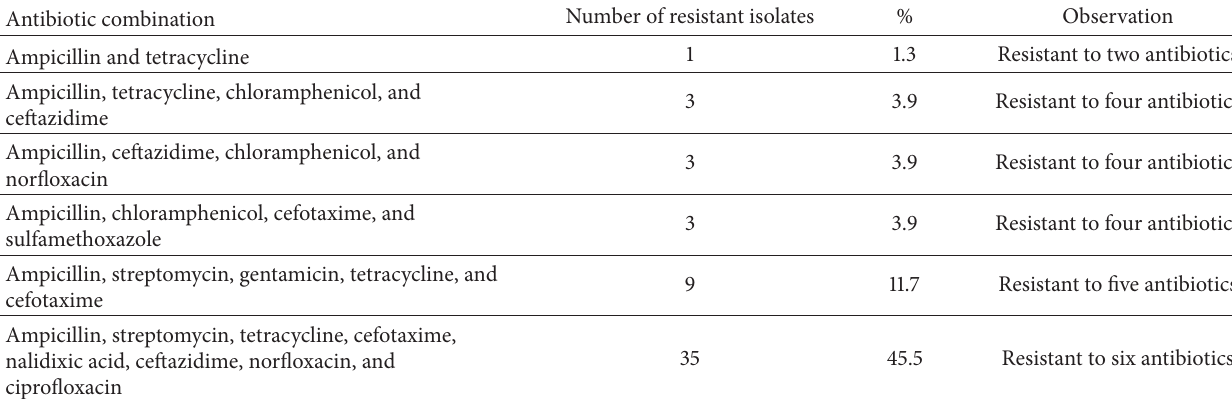
Table 3: Antibiotic resistance patterns of E. coli